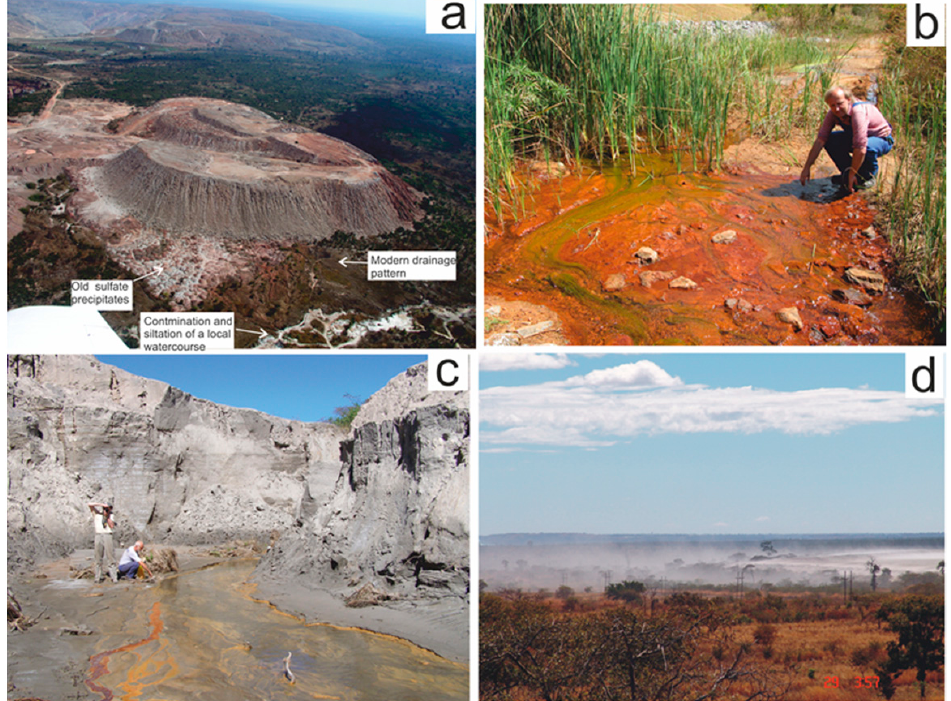
Figure 2. Main sources of contamination in the Zambian Copperbelt. ( a ) Mimbula Open Pit waste rock dump (the Chingola region). Soluble sulfates and fine fractions of the deposit were washed out and deposited on a local drainage pattern. Aerial photography. ( b ) Leaking of water from the flotation tailings dam in Chingola results in the formation of iron-rich precipitates which contain from 25% to 40% Fe 2 O 3 and a range of trace elements (As, Co, Cr, Cu, Hg, Mo, Ni, Se, and Zn). ( c ) Collapse of the flotation tailings dam results in a massive siltation of local watercourse in the Luanshya Mining District. ( d ) Sandstorm over a dry beach of the active Mindolo Flotation tailings impoundment west of the Kitwe Township. The dust from the impoundment contaminates the agricultural land in its wide vicinity. The author of the photos: Bohdan Kˇr í